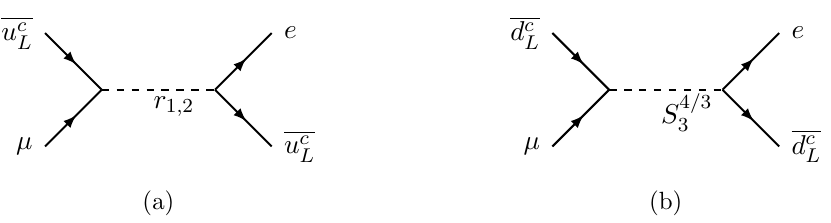
Figure 6 . Tree level processes contributing to (cid:22) to e conversion in nuclei. Note the notation in the left diagram represents two diagrams, one mediated by r 1 and another by r 2 . The arrows here, as in all other diagrams in this paper. represent the chirality of the (cid:12)eld. Arrows pointing towards the vertex represent left-handed